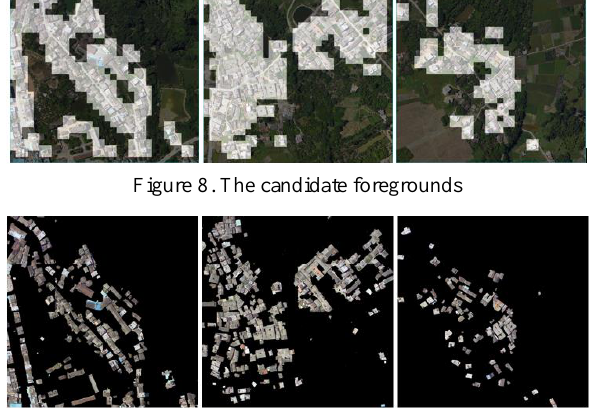
Figure 9. The segmentation results